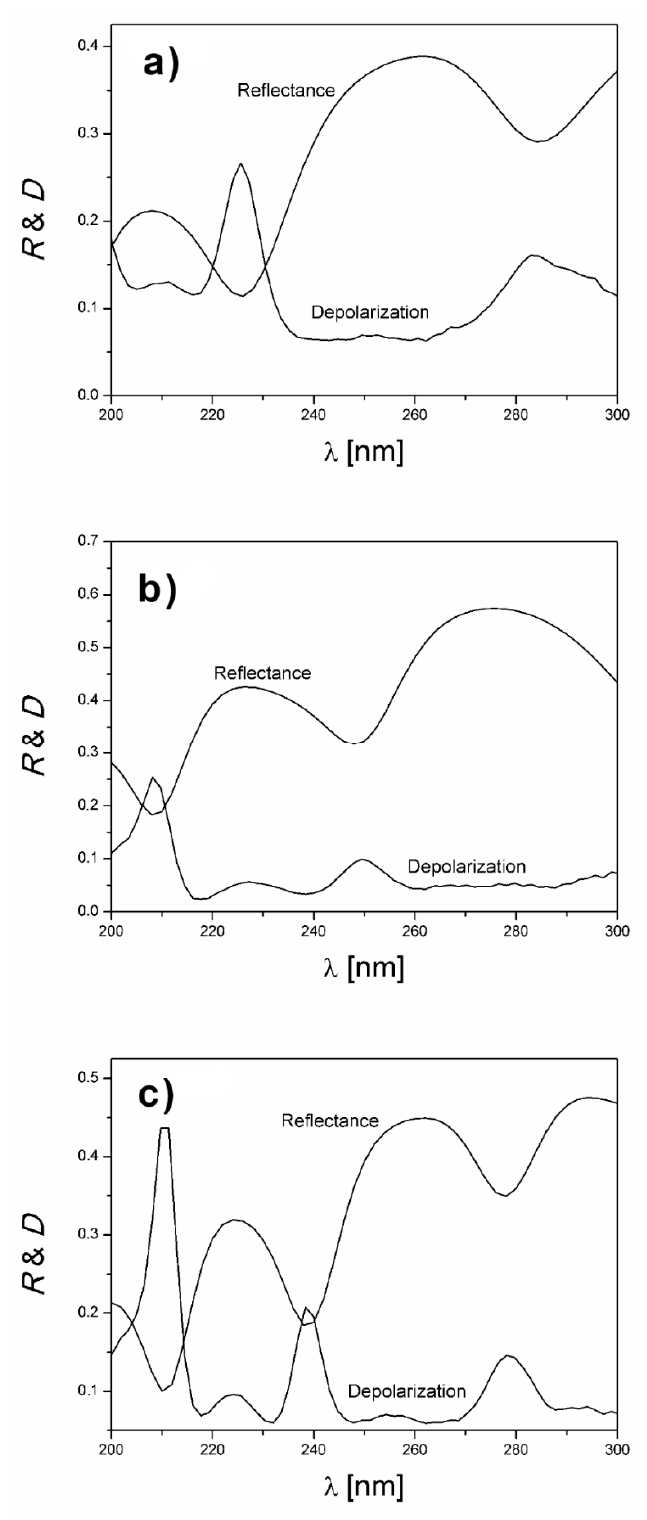
Figure 9. Spectral dependence of depolarization, D , and reflection, R . coefficients of porous SiO 2 films: ( a ) Sample P1, ( b ) sample P2, ( c ) sample P3. ( a ) Sample P1, ( b ) sample P2, ( c ) sample